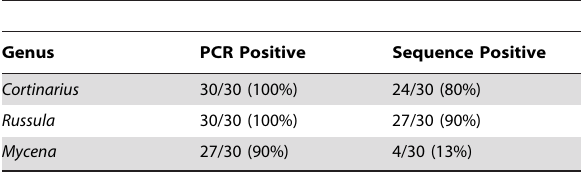
Table 1. Improvement of PCR and sequencing success rates using ITS1